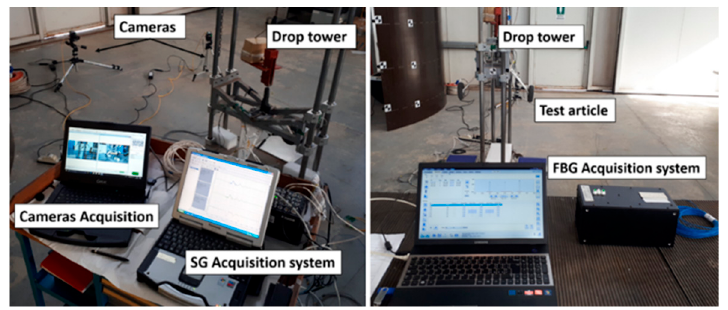
Figure 10. SG and cameras acquisition systems ( left ); FBG acquisition system ( right ).